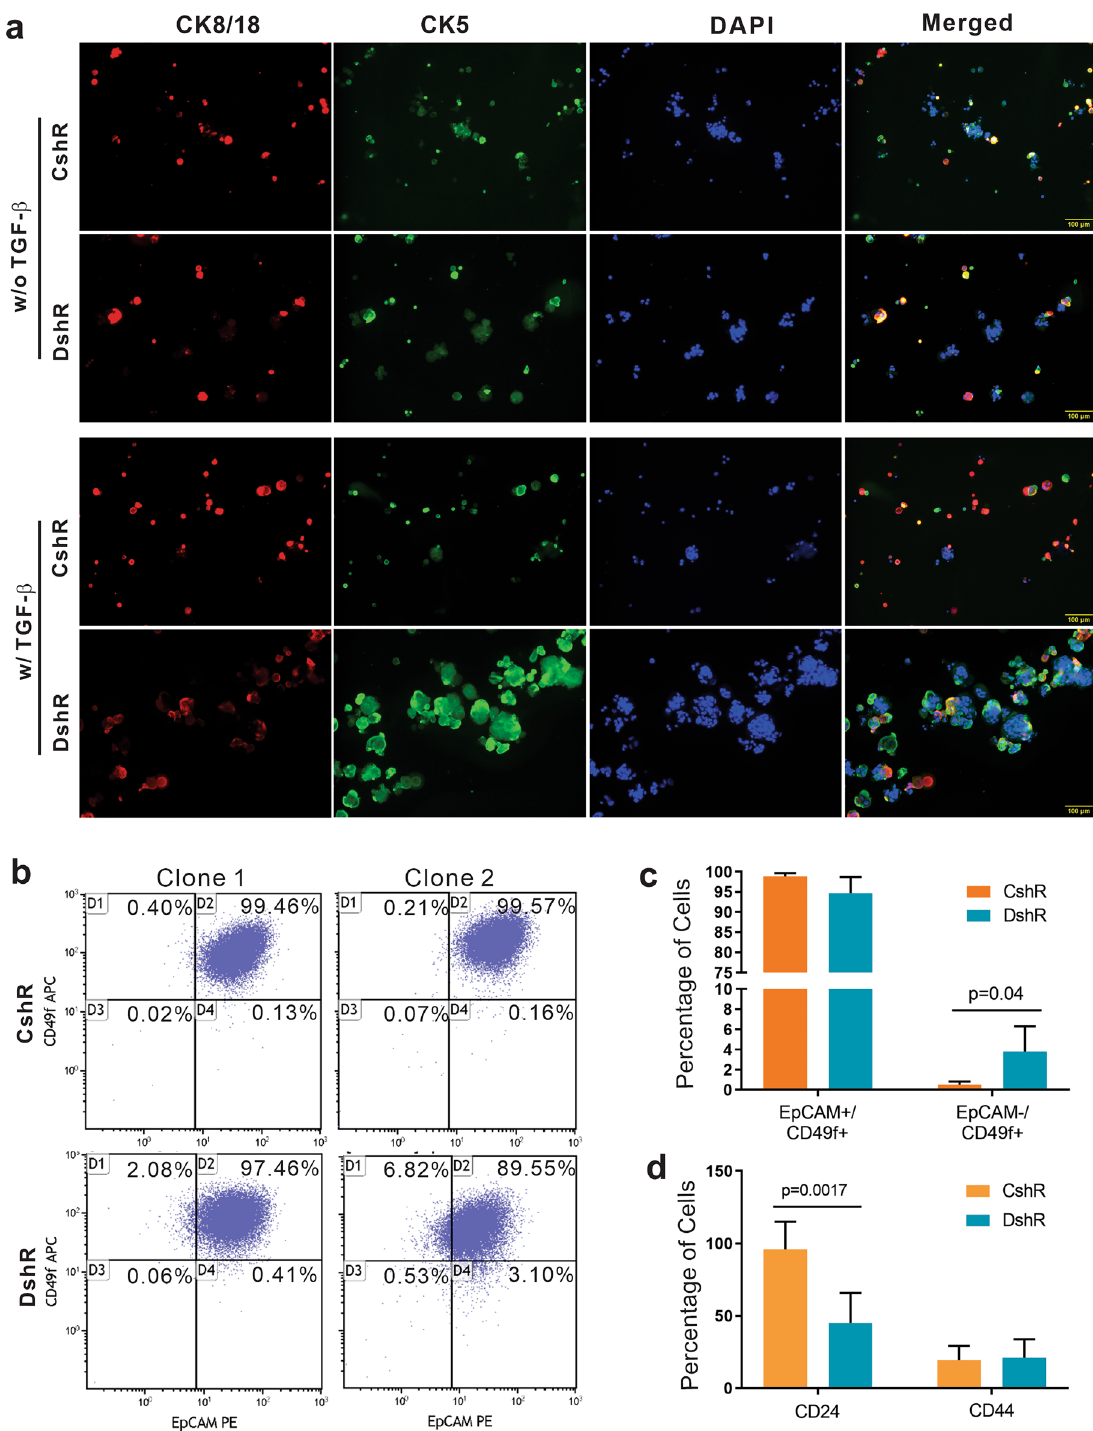
Figure 3. The effect of DEAR1 -KD on luminal and myoepithelial/basal surface marker expression in HMEC cells. ( a ) Images at ×10 magnification of staining of 76N-E6 control (CshR) and DEAR1 -KD (DshR) clones grown in 3D mammosphere culture in the absence (top) or presence (bottom) of TGF-β with luminal and myoepithelial/basal cytokeratin surface markers, CK 8/18 (red) and CK 5 (green), respectively. Fluorescence images were taken using OLYMPUS cellSens Software and scale bars equal 100 µm. ( b ) FACS data showing proportion of cells that express EpCAM and CD49f from 2 CshR clones (top) and 2 DshR clones (bottom). ( c ) Bar plots showing the mean ± SD percentage of cells displaying luminal (EpCAM + /CD49f + ) and basal (EpCAM − /CD49f + ) surface markers from CshR (orange) and DshR (teal) clones. p-values were calculated using a two-tailed Student t-test between groups. ( d ) Bar plots quantifying FACS data assaying CD24 and CD44 protein expression from CshR (orange) and DshR (teal) clones. p-values were calculated using a two-tailed Student t-test between